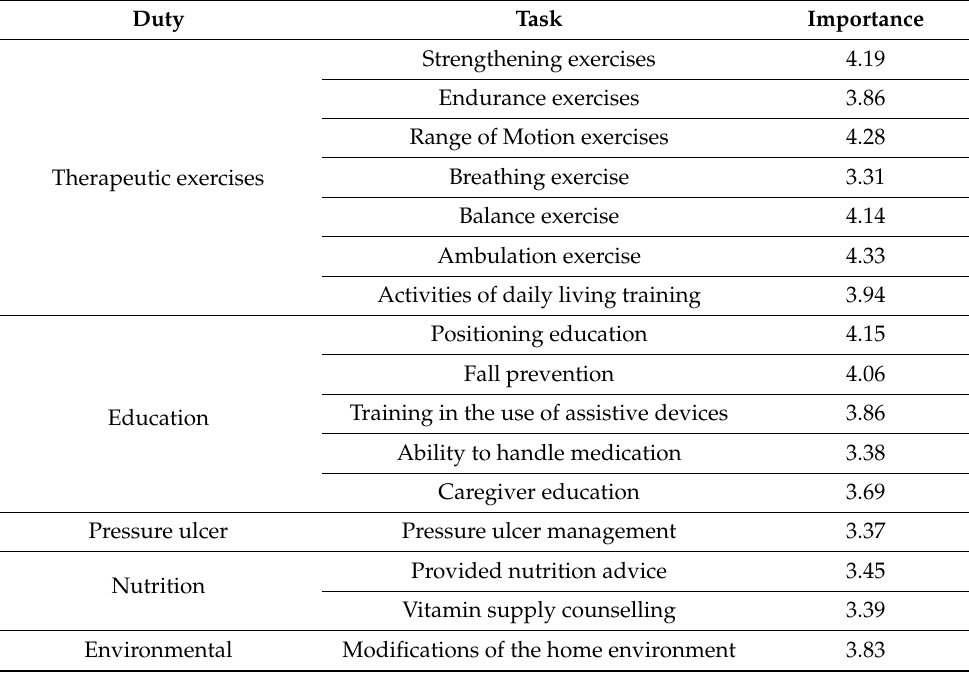
Table 4. The importance of the components of home-based rehabilitation programs for patients undergoing hip fracture surgery ( n =